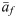

(a) The Pearson coefficient of correlation ρ of the attractiveness between the two coupled individuals in different systems. ρ is strongest in fully-connected systems. In sparse networks, ρ increases monotonically with the average degree ⟨k⟩ and decreases with the degree diversity. For all cases investigated, system size is 2N and N = 10,000. (b) The average attractiveness a¯f of individuals in the set f who are matched with those in a subset of m with attractiveness in the range [a
m−0.05, a
m+0.05) for a series of points a
m. In fully-connect systems, the less attractive individuals are bound to be coupled with ones who are also less attractive. In sparse networks, however, they are coupled with ones who are more attractive. (c) The attractiveness contour figure of the coupled individuals in Erdős-Rényi networks with average degree ⟨k⟩ = 5. A pattern emerges even when similarity is not the motivation in seeking partners. a
m and a
f are the attractiveness of nodes in sets m and f, respectively. (d) The attractiveness contour figure of the coupled individuals in fully-connected systems. The correlation is strongest towards the less attractive individuals (the circled part).